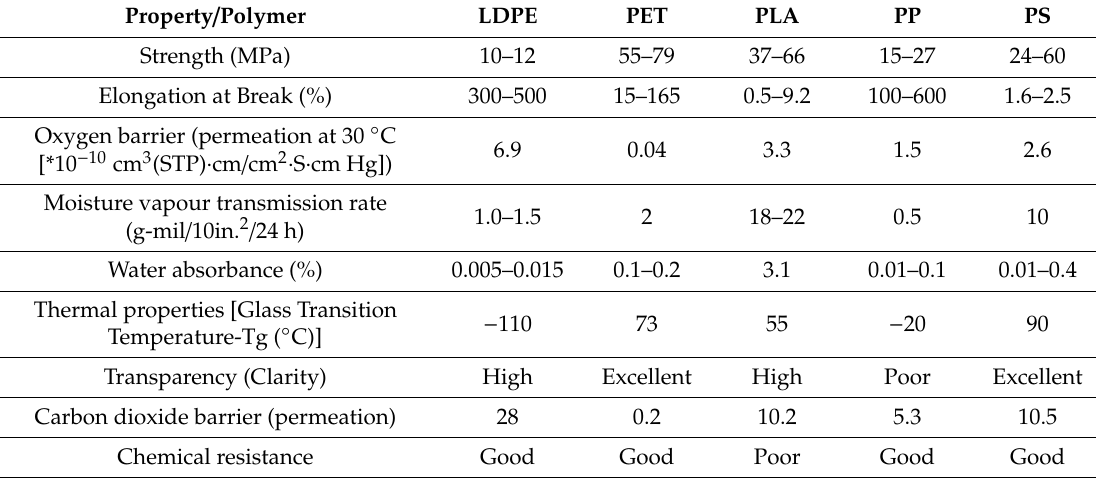
Table 2. Comparison of PLA properties to other common polymers used in food packaging. Data from